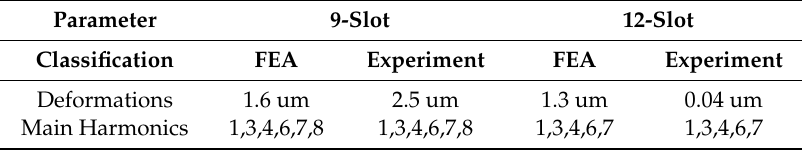
Table 2. Deformation analysis of the results of PMSMs according to